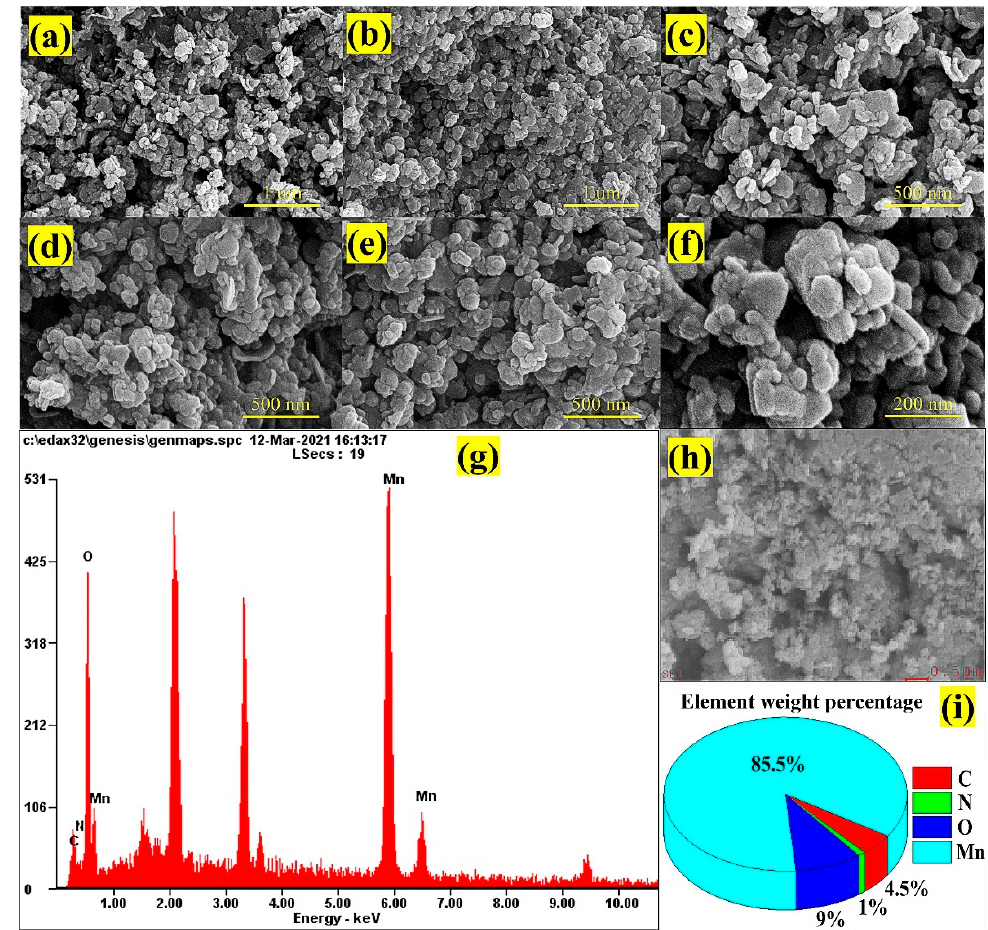
Figure 3. ( a – f ) High-resolution SEM images of NGO@MnO 2 under different magnification levels. ( g – i ) EDX profile.